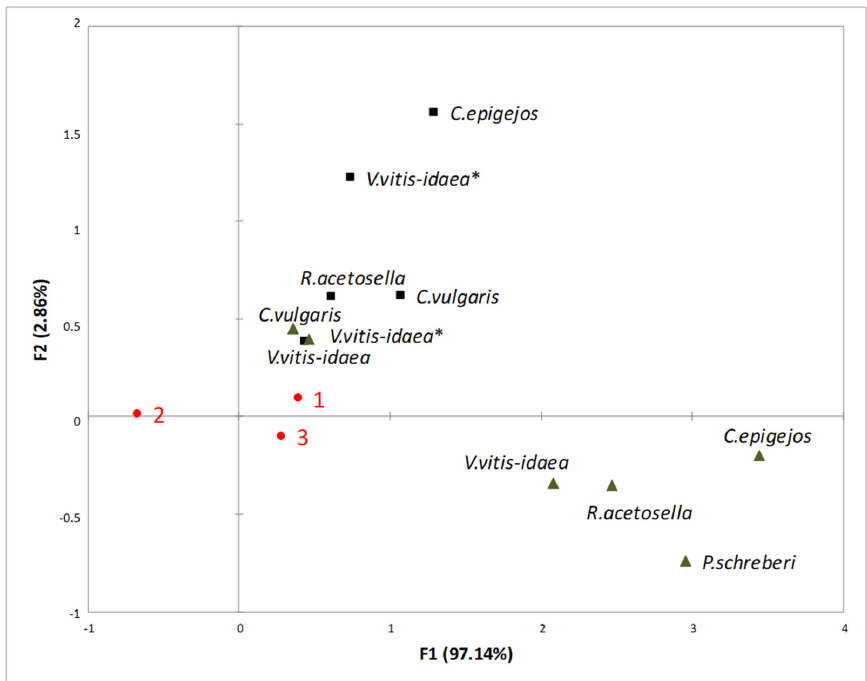
Figure 3. RDA of the impact of the shoots (black triangles) and roots (black squares) of plant-donor aqueous extracts on radicle length at different climate conditions (1—Current environmental conditions (21.5/16 ◦ C and 400 ppm CO 2 concentration), 2—temperature increases of 4 ◦ C compared to the current conditions (25.5/20 ◦ C and 400 ppm CO 2 concentration), 3—increasing temperature with higher CO 2 concentration conditions (25.5/20 ◦ C and 700 ppm CO 2 ). (*): dominant species of 2-year-old clear-cuts.